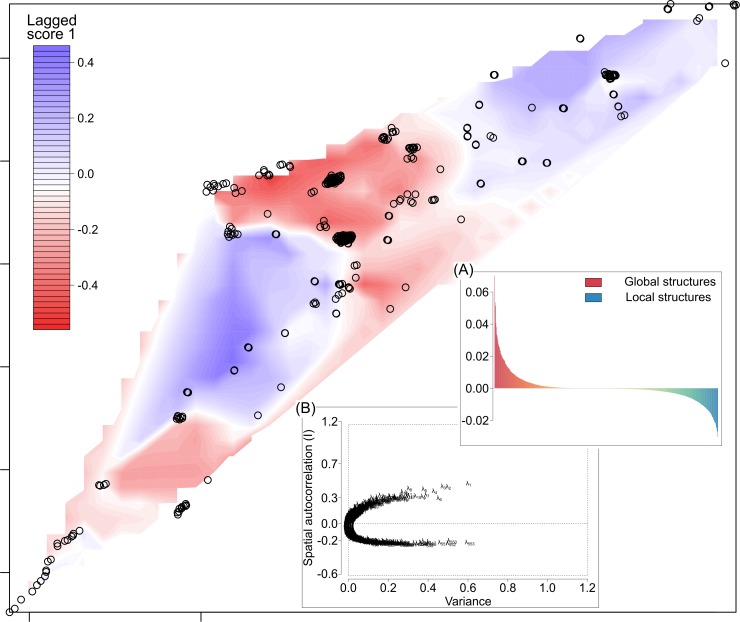
Spatial principal component analysis of lake trout showing the first global structure across Mistassini Lake.Plotted are the lagged scores in which colours (blue to red) represent the score of an individual genotype; each is positioned by its spatial coordinates. Inset is the barplot for all eigenvalues (A), and the screen plot (B) which illustrates the spatial and variance components of those eigenvalues.